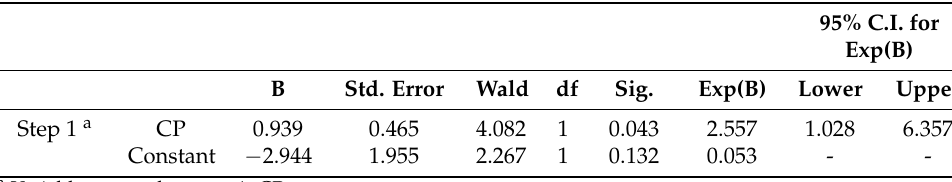
Table 26. Competitive pressure: regression analysis for IaaS.